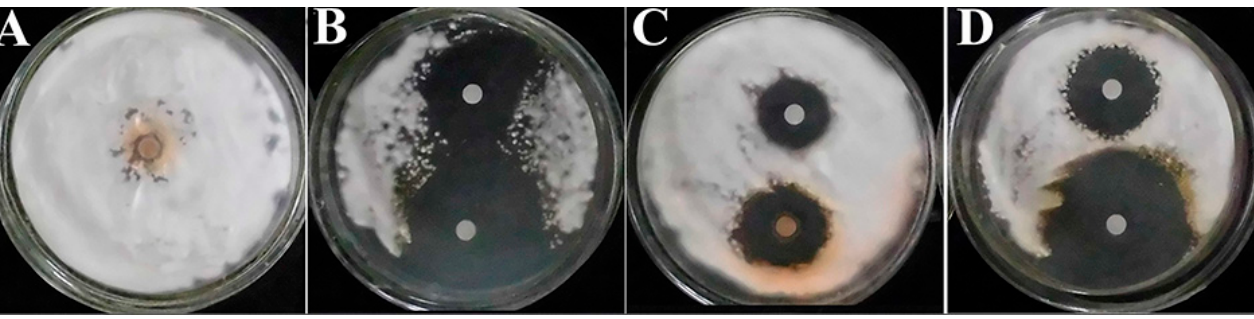
Figure 1. Disc diffusion test. ( A – D ) represent control, terbinafine, neral, and geranial treatments, respectively; the upper inhibition zones were formed by minimum inhibitory concentration, and the lower ones were formed by minimum fungicidal concentration.